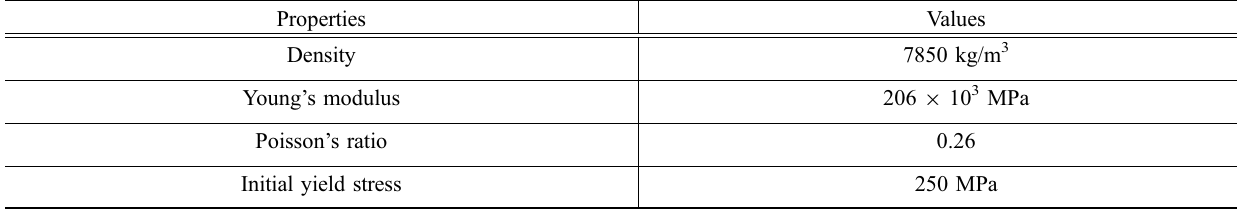
Table 3 Steel properties for tip-over simulation.